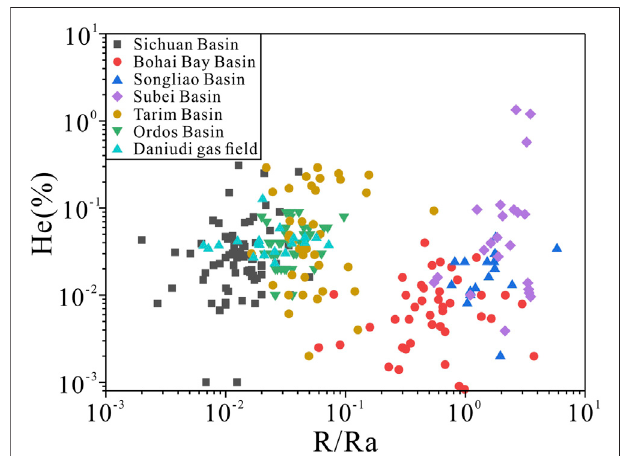
FIGURE 4 | Distribution of the R/Ra ratios of natural gas in Ordos Basin (Dai et al., 2017) and the Daniudi gas fi eld.